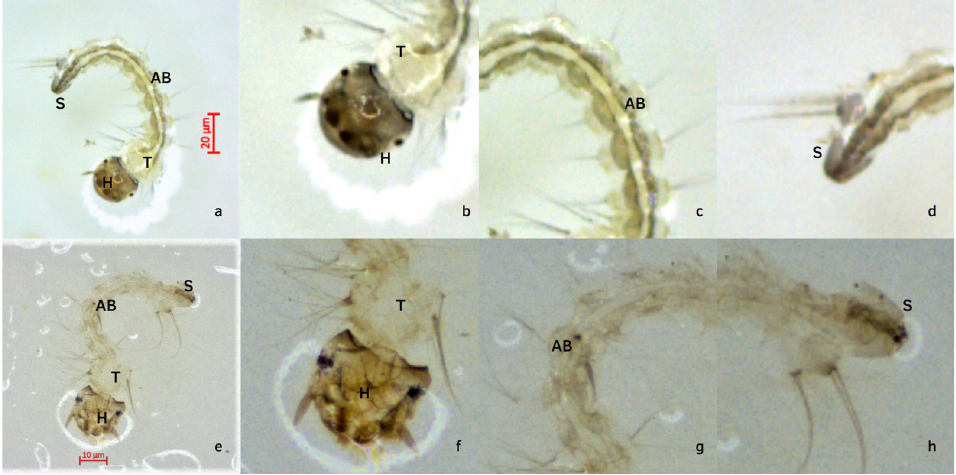
Fig 1. Alterations in morphological aspects of RHA-treated larvae. Concentration of extract (RHA): 0.3 mg/mL; Time of exposure: 24h; A-D: Control larva showing normal coloration of cuticle and others morphological aspects; e-h: RHA-treated larva showing discoloration of cuticle and morphological alterations; f: discoloration in the head (h) and thorax (t) of RHA-treated larva; g: abdomen (ab) discoloration of RHA-treated larva; h: few morphological changes in the siphon (s) of RHA-treated